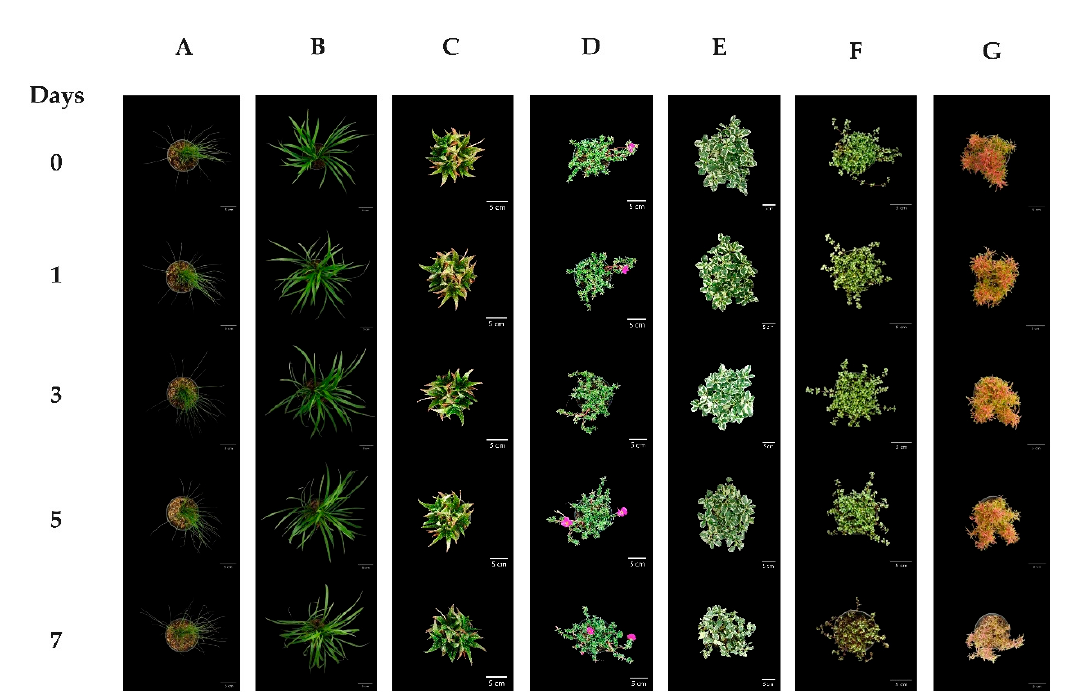
Figure A1. Images of plants under the drought stress treated condition at 5 time intervals: 0, 1, 3, 5, and 7 days after the start of the experiment ( Allium schoenoprasum : A, Liriope Muscari: B Aloe Sp : C, Sedum x rubrotinctum : D, Alternanthera ficodea : E, Pilea libanensis : F, Plectranthus scutellarioides : G).